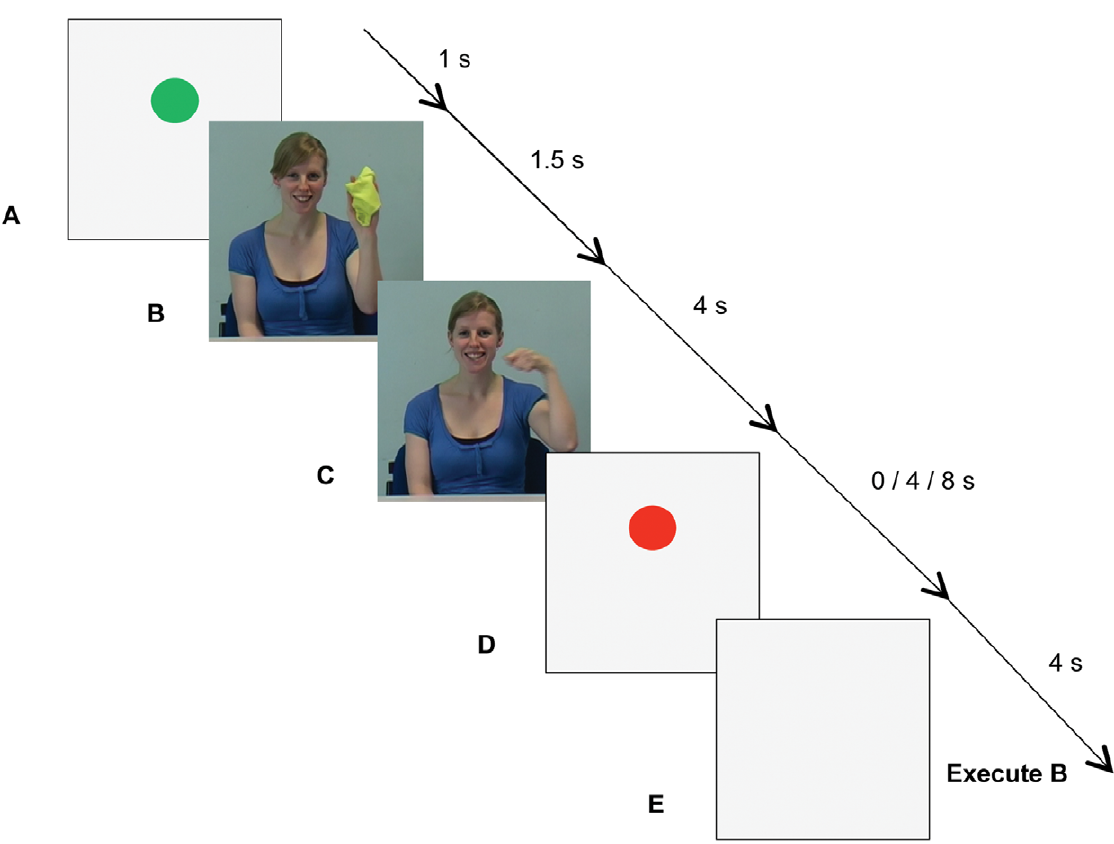
Figure 2. Sequence of events in the automatic imitation experiment. (A) A green circle appeared when participants placed their fingers in the start location. (B) Then a picture of the to-be-pantomimed (imperative) action was shown, followed by (C) a distractor movie of the model pantomiming either the same or a different action. (D) In blocks with delayed execution, a red circle was shown for either 4 or 8 s. (E) Execution of the imperative action was cued by display of a neutral, light-grey background, which appeared at the offset of either the distractor movie or the red circle.